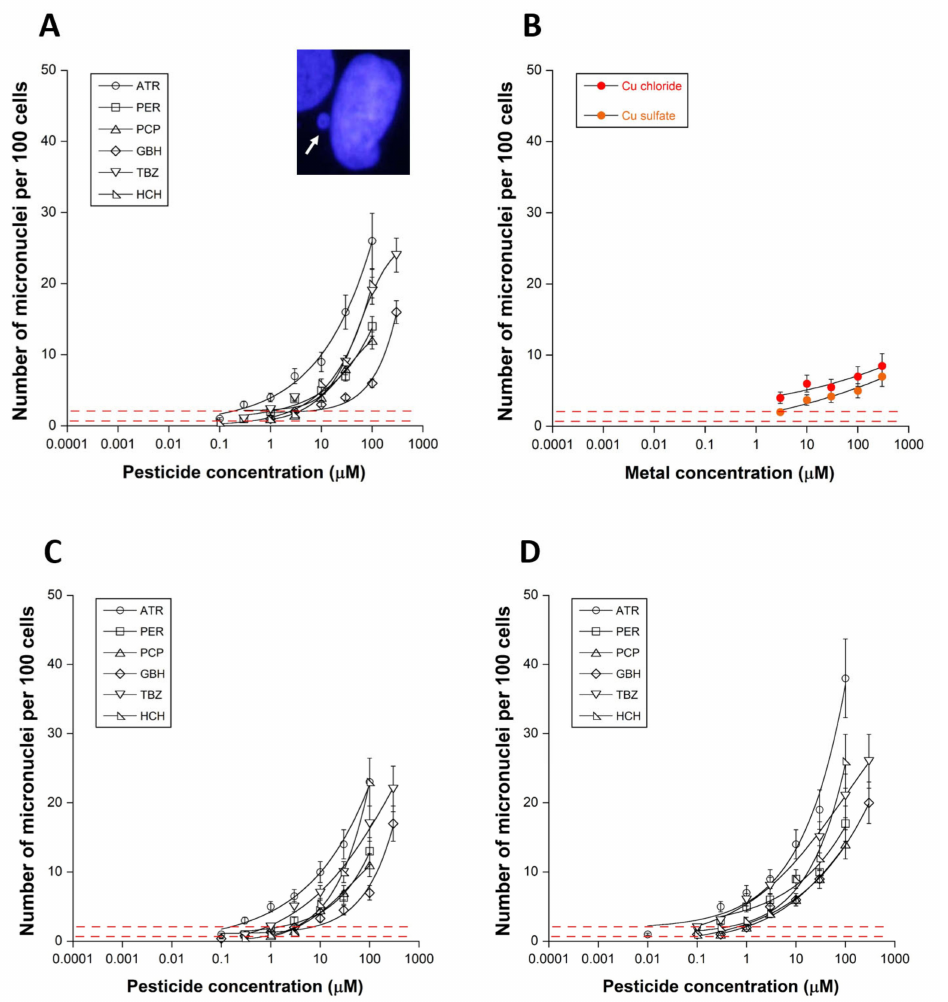
Figure 2. Residual micronuclei after exposure to pesticides and metals. Number of micronuclei per 100 cells in the human untransformed RIANS-normal radioresistant 1BR3 cells after incubation for 24 h with the indicated concentration of pesticides ( A ) or with CuSO 4 and CuCl 2 solutions ( B ). Number of micronuclei per 100 cells in the human untransformed RIANS-normal radioresistant 149BR ( C ) and RIANS-delayed 08HNG ( D ) cells after incubation for 24 h with the indicated concentration of pesticides. Each plot represents the mean ± standard error (SEM) of four replicates. Insert: Representative examples of γ H2AX and DAPI-counterstained images obtained at 1 µ M TBZ. White bar represents 5 µ